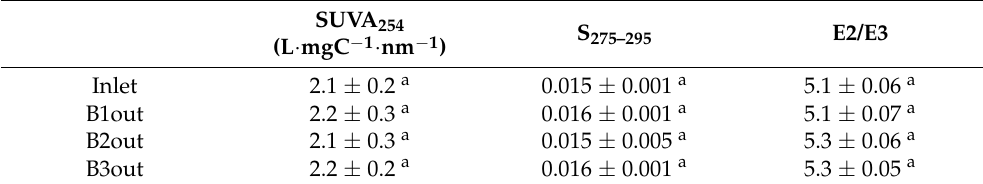
Table 3. UV-visible indices (SUVA 254 , S1 and E2/E3) of the inlet and the three outlets (B1out, B2out and B3out) ( n = 21). Values to the right of ( ± ) are the standard deviations. Values with different superscript letters (a) within each parameter are significantly different ( p < 0.05).